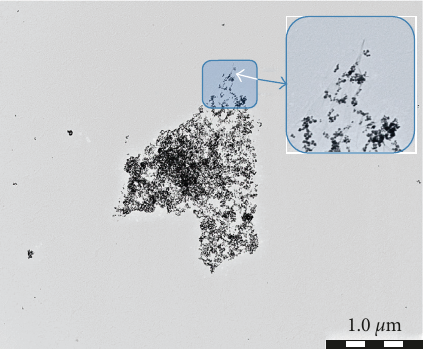
Figure 6: Electron micrograph of 1/10 mass ratio GO/MNP composite at low magnification. The inset shows the enlarged edge region of the imaged particle. The scale bar refers to 1 µ m